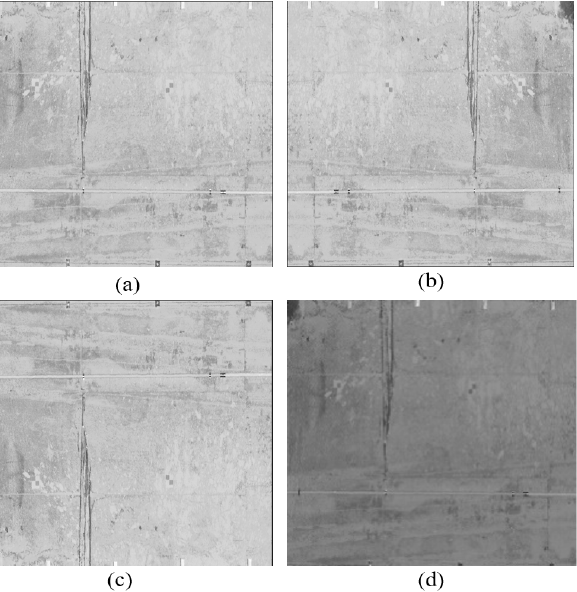
Figure 8. Sample images in the dataset: ( a ) the original picture; ( b ) after flipping left and right; ( c ) after flipping up and down; ( d ) after contrast stretching.